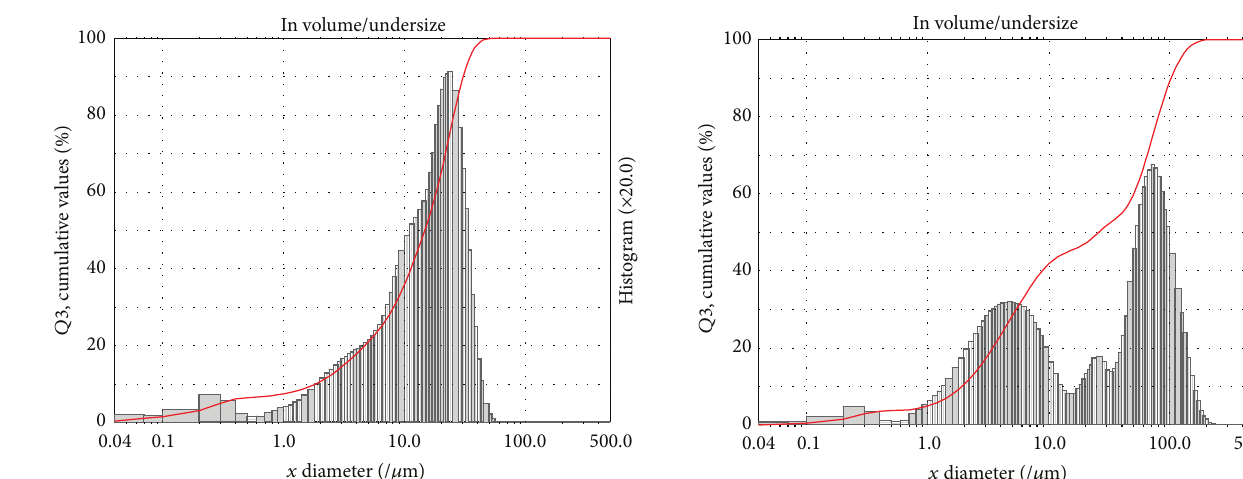
50 to 100 𝜇 m while the minor peak ranges from 2 to 10 𝜇 m. The average particle diameter reported was 41.79 𝜇 m.